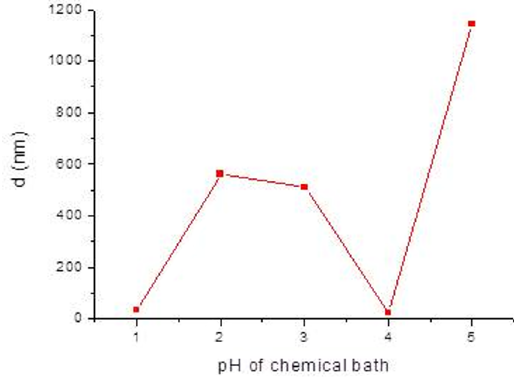
thin films produced at different x